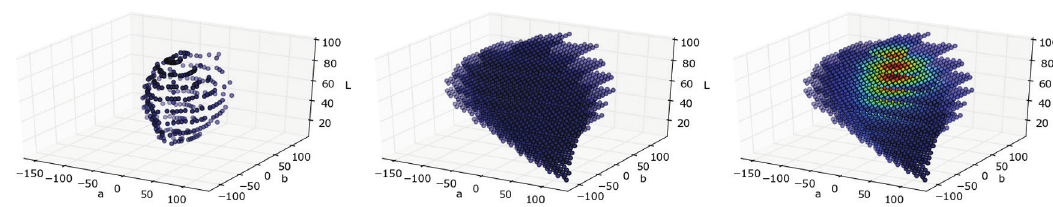
Figure 4: Different state spaces used in our models: the first is based on the Munsell array, the others are based on an esti- mate of the visible spectrum by Masaoka et al.; the first two have uniform priors, whereas the third has more realistic priors (closer to red indicating higher probability here). Given that state spaces are three-dimensional, these plots can never provide a full picture of the state spaces. They only serve to illustrate differences in shape and prior probabilities between them. The full data is available online (Correia, “COM State